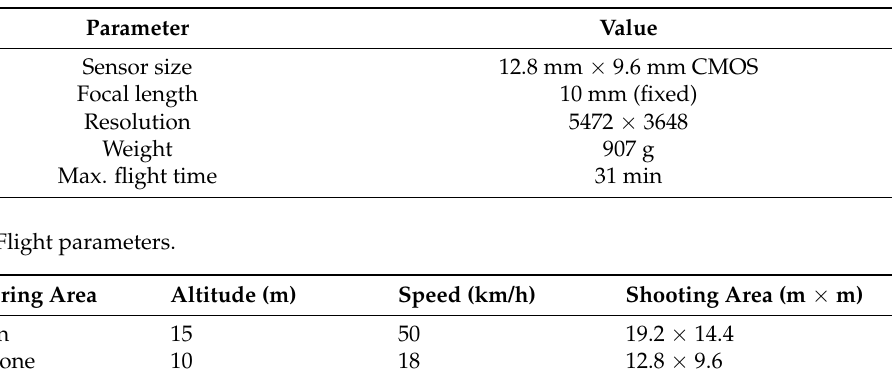
Table 1. UAV basic parameters.